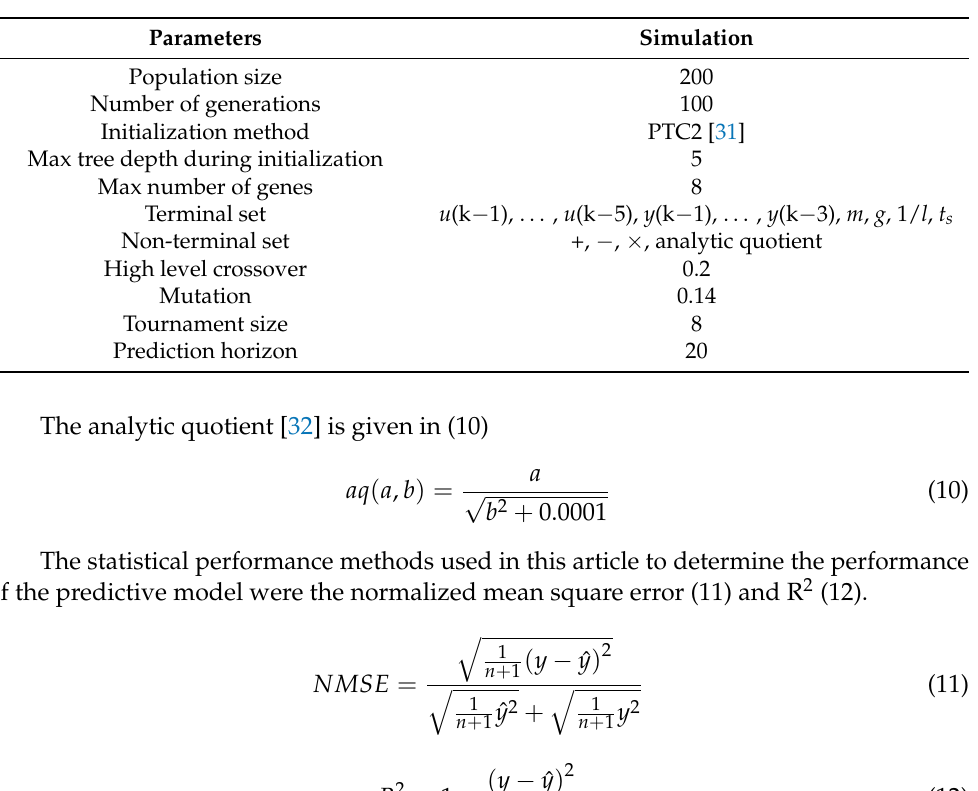
Table 2. Multi-gene genetic programming parameters for simulated